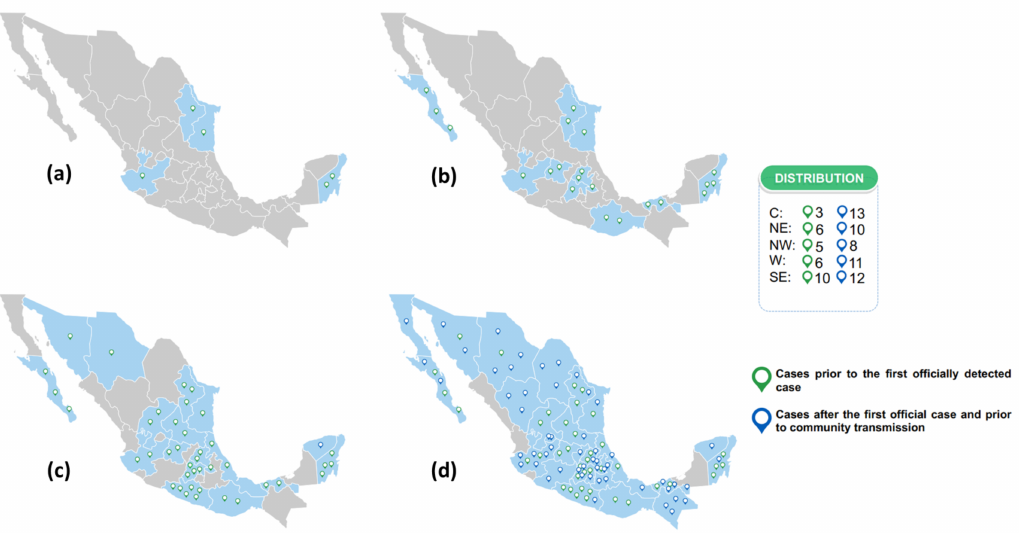
Figure 2. Number of cases detected before the first officially reported case and before community transmission in the country: ( a ) cases detected in epidemiological week 7, ( b ) cases detected until epidemiological week 8, ( c ) cases detected until epidemiological week 9, ( d ) cases detected until epidemiological week 12. Dates considered for the report of cases before the first officially reported: from 02/10/2020 to 02/27/2020 (green symbol). Dates considered for reporting cases before community transmission: until 03/23/2020 (blue